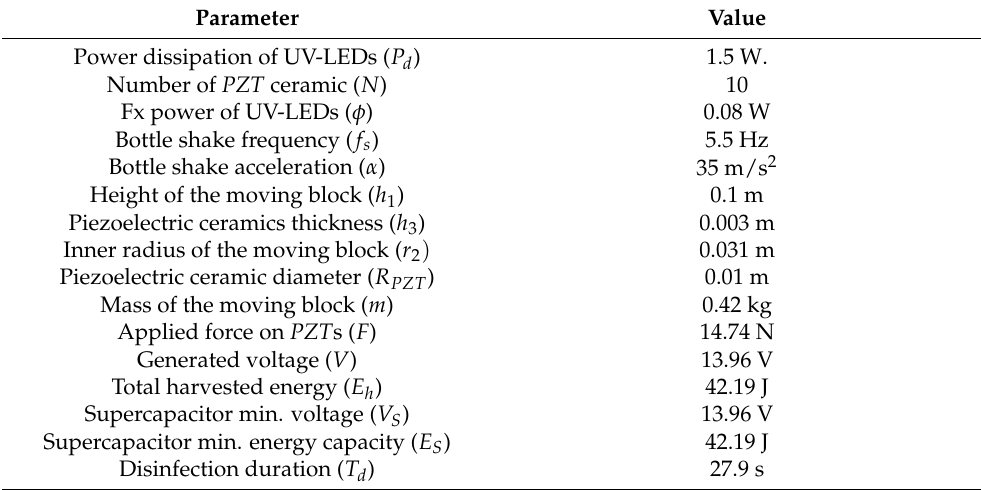
Table 5. Optimal System Parameters (Objective Function (OF): Shake